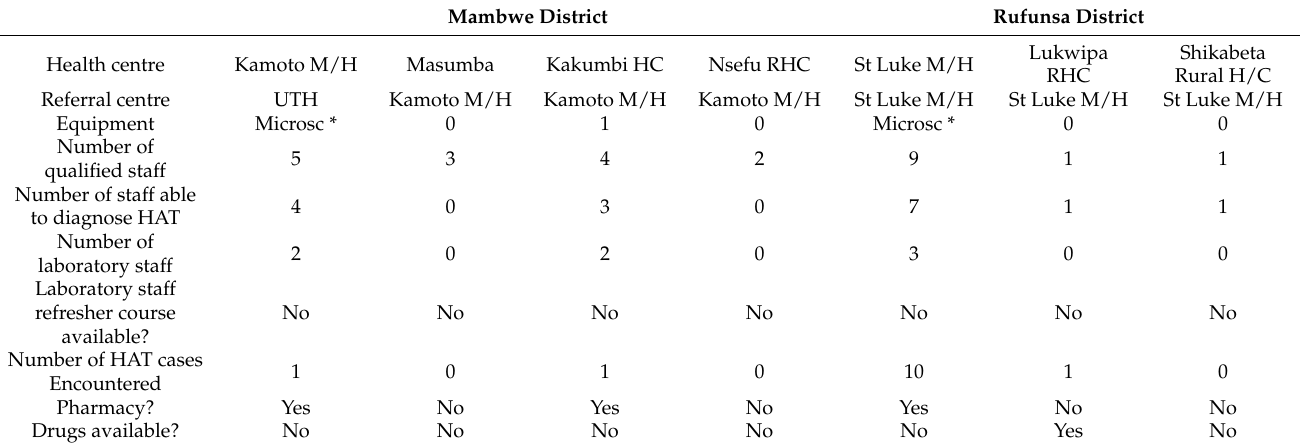
Table 3. Adequacy of the healthcare delivery system for the management of rHAT in Mambwe and Rufunsa districts.